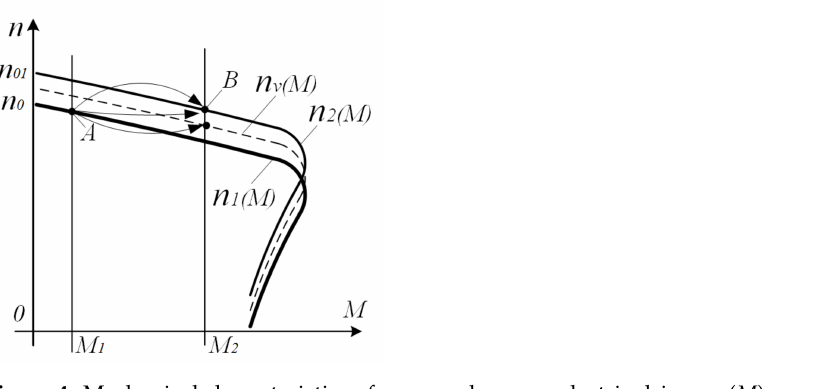
Figure 4. Mechanical characteristics of an asynchronous electric drive. n 1 ( M ), mechanical charac- teristics without compensation with scalar control; n v ( M ), with compensation; n 2 ( M ), intermediate version. A is the operating point at minimum load. B is the operating point after loading.